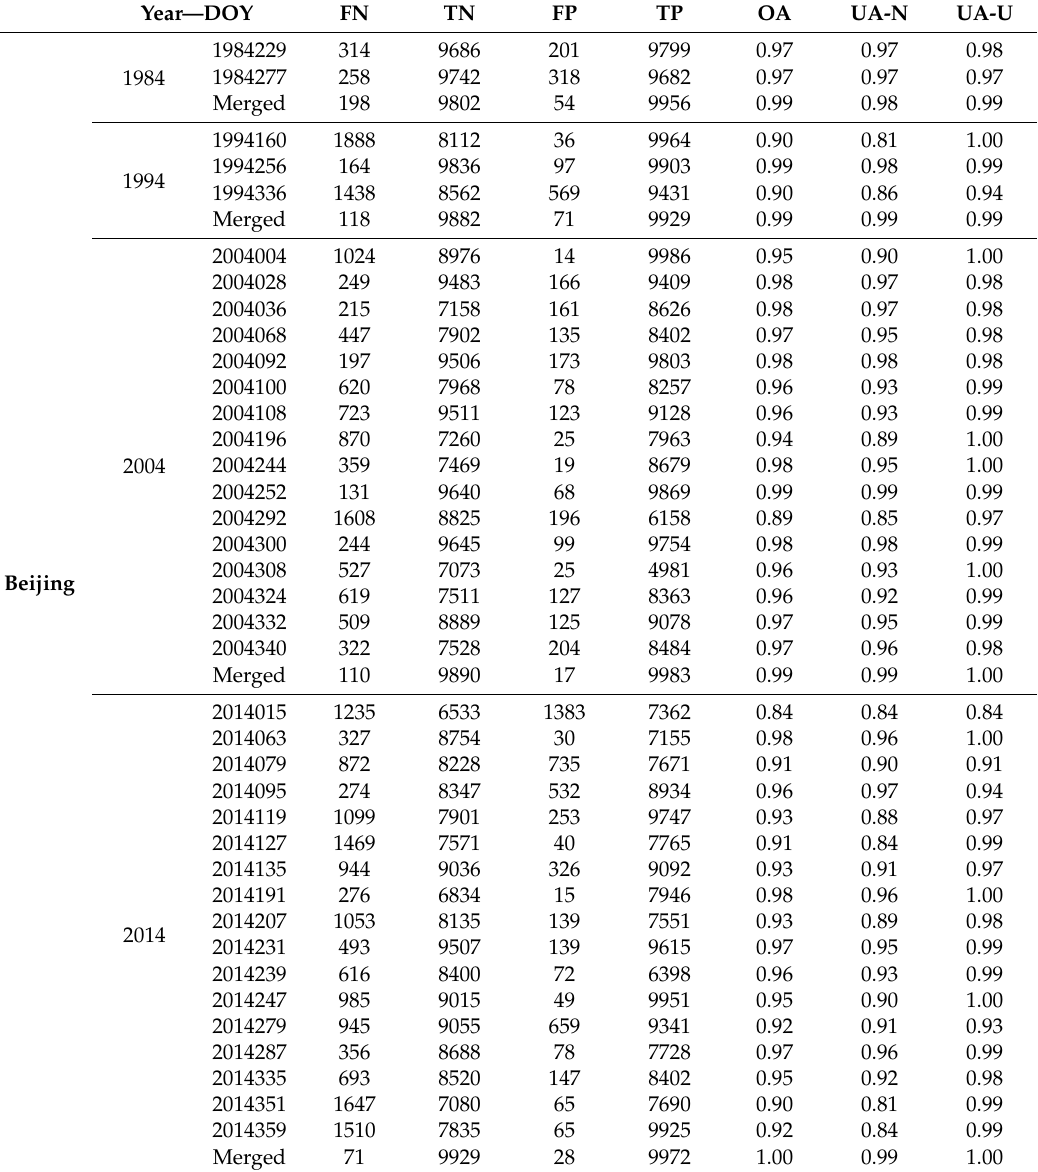
Table 1. Classification performance in specific